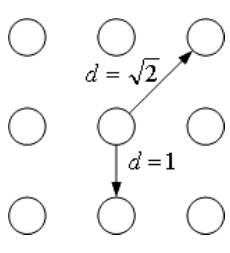
Figure 2. Linking distance between two neurons.